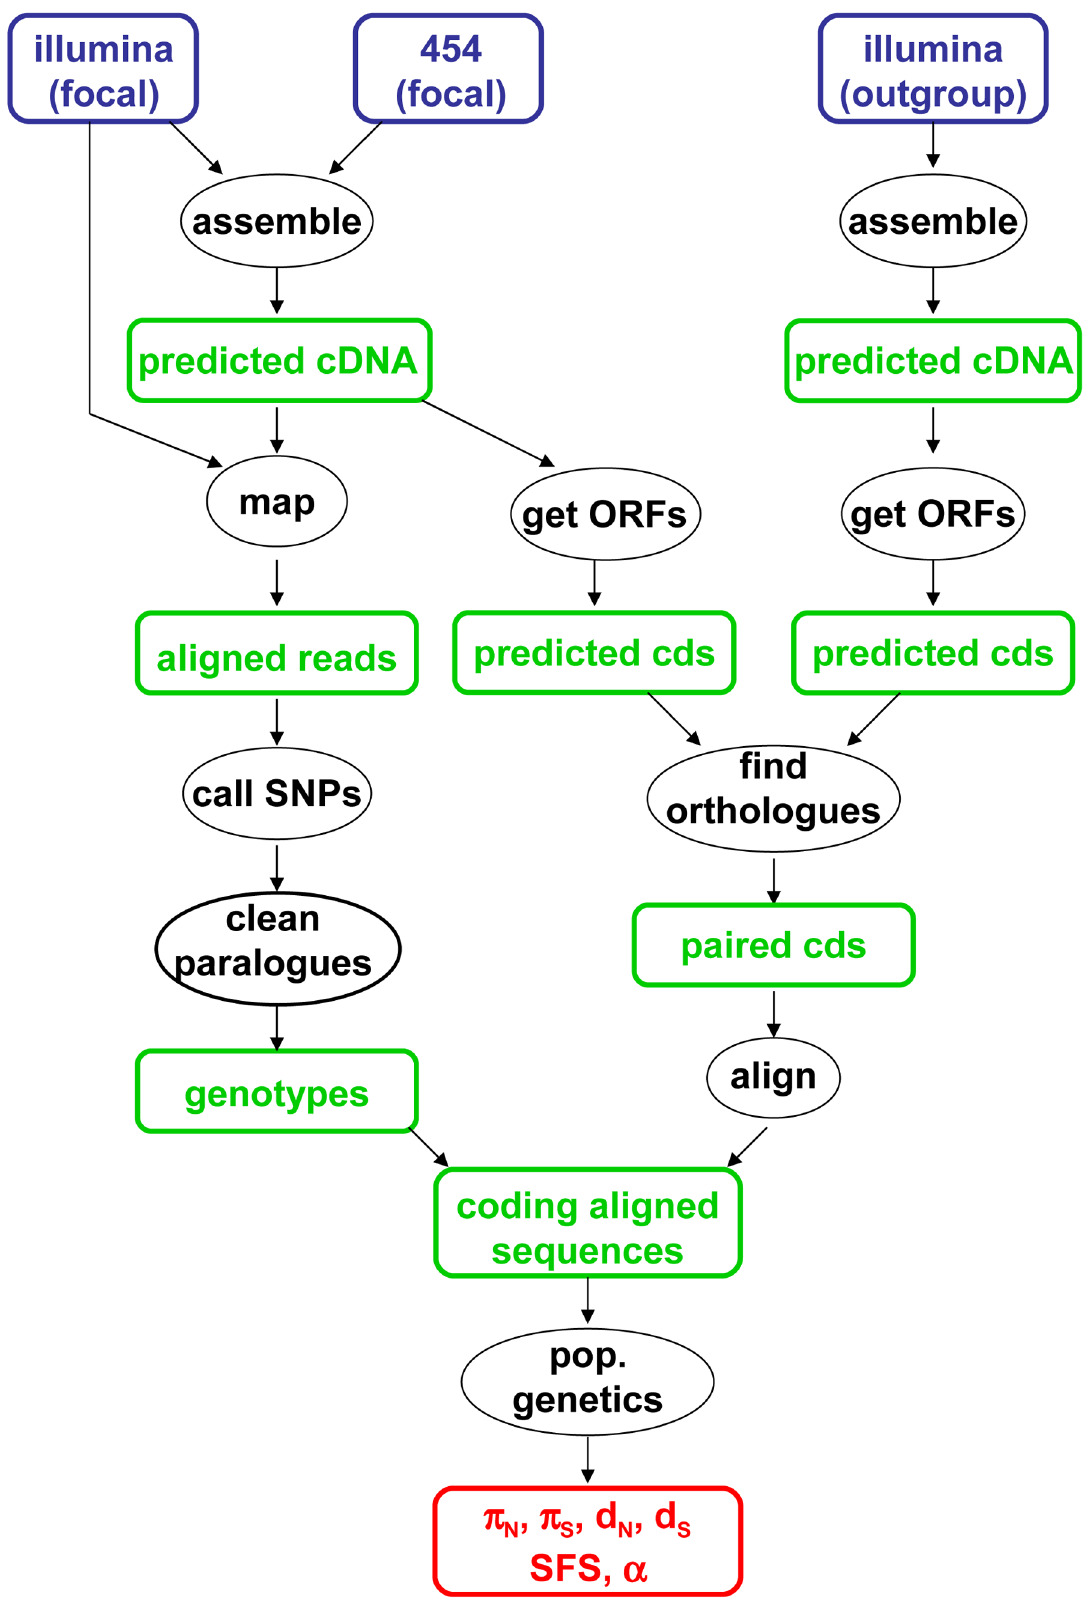
Figure 1. Main data analysis pipeline used in this study.